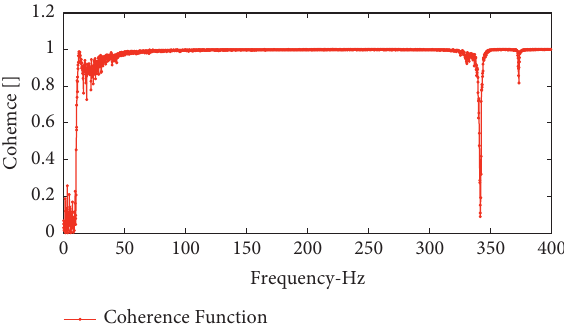
Figure 10: Coherence function of tip accelerometer in two modes vibration range (random excitation force 10.8N).